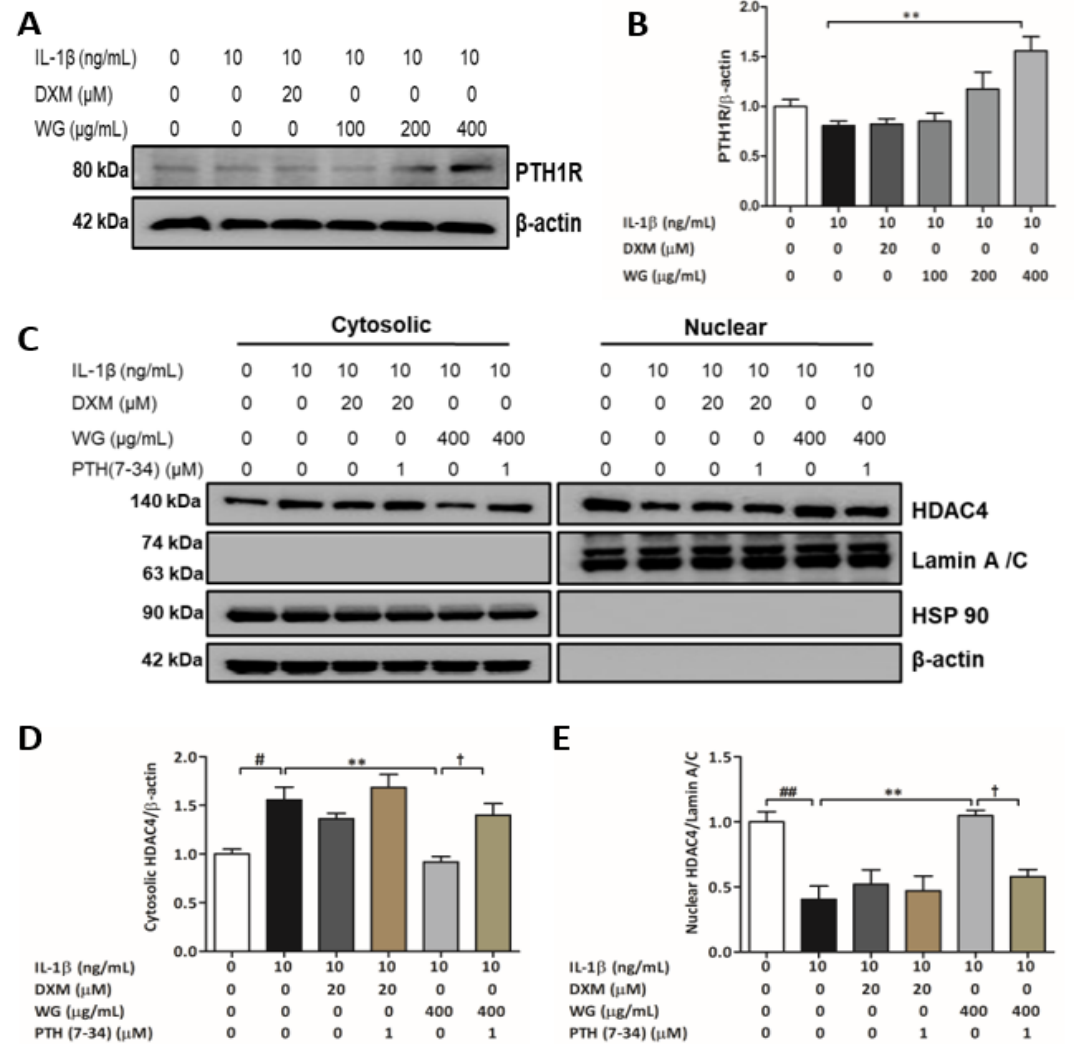
Figure 4. Effect of WG on PTH1R. ( A ) Western blot analysis of PTH1R. ( B ) Quantitative analysis of PTH1R relative to β -actin. SW1353 cells were pre-treated with indicated concentration of WG or DXM for 4 h in 0.2% BSA media followed by IL-1 β for 24 h. ( C ) Western blot analysis of cytosolic and nuclear fractions using HDAC4 antibody, ( D ) quantitative analysis of cytosolic HDAC4 relative β -actin, ( E ) quantitative analysis of nuclear HDAC4 relative to Lamin A/C. SW1353 cells were pre-treated with WG or DXM for 4 h in 0.2% BSA media in the presence or absence of PTH (7 – 34) followed by IL- 1β for 24 h. (# p < 0.05 and ## p < 0.01 vs. control; ** p < 0.01 vs. IL- 1β; † p < 0.05 vs. WG).